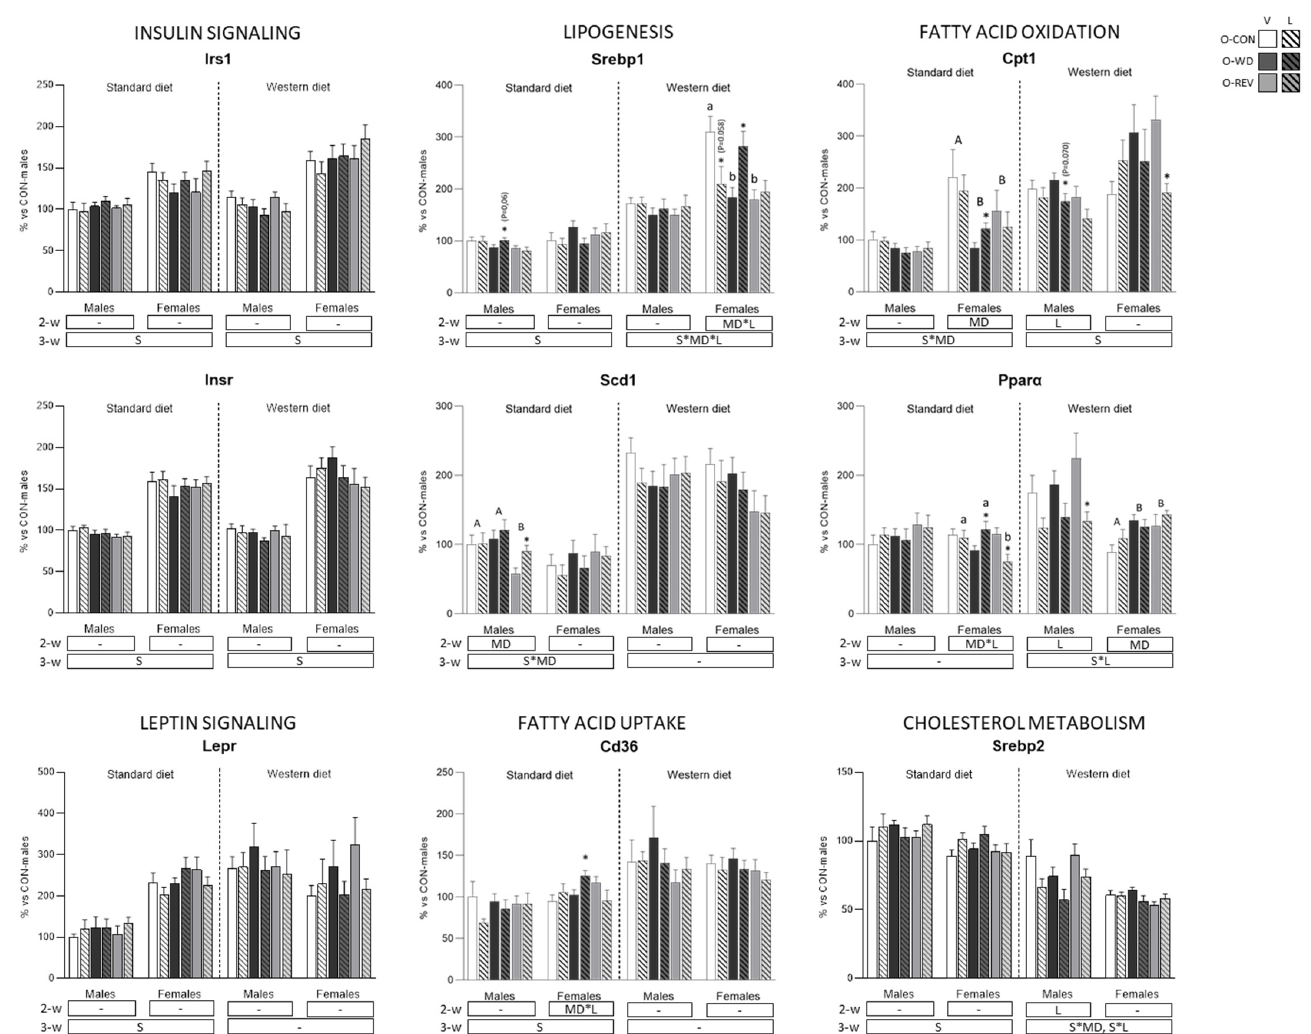
Figure 7. Expression levels of genes related to energy metabolism in liver of O-CON, O-WD and O-REV male and female animals treated with vehicle or leptin during suckling and fed SD or WD from weaning, at four months of age. Data are mean ± SEM ( n = 8–12). Statistics: After data separation depending on post-weaning diet, three-way ANOVA was performed to analyze the effect of sex, maternal diet and/or leptin treatment. In each sex, two-way ANOVA was performed to analyze the effect of leptin treatment and/or maternal diet. When an interactive effect was found, one-way ANOVA was performed to analyze the effect of maternal diet in each treatment. Single comparisons between leptin versus vehicle-treated rats of all experimental groups were carried out using Mann-Whitney U test. Symbols: sex (S), maternal diet (MD), leptin treatment (L); A ≠ B ( p < 0.05, LSD post-hoc, two-way ANOVA); a ≠ b ( p < 0.05, LSD post-hoc, one-way ANOVA); *, different from their vehicle-treated equal ( p < 0.05, Mann-Whitney U test). Abbreviations: offspring of CON-dams (O-CON), offspring of WD-dams (O-WD), offspring of REV-dams (O-REV), vehicle (V), leptin